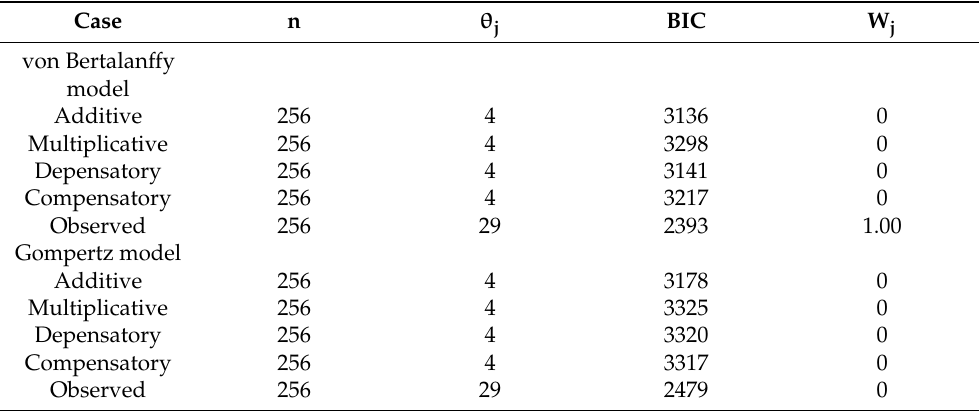
Table 2. Mean and 95% confidence intervals for the parameters using five error structures for the two growth models tested. t 0 corresponds to the age at zero length of von Bertalanffy and t 1 to the inflexion point of the Gompertz model. L (cid:2998) is the asymptotic total length. For the von Bertalanffy model, k is the growth or Brody coefficient. For the Gompertz model, k g is the instantaneous growth rate at age t 1 .